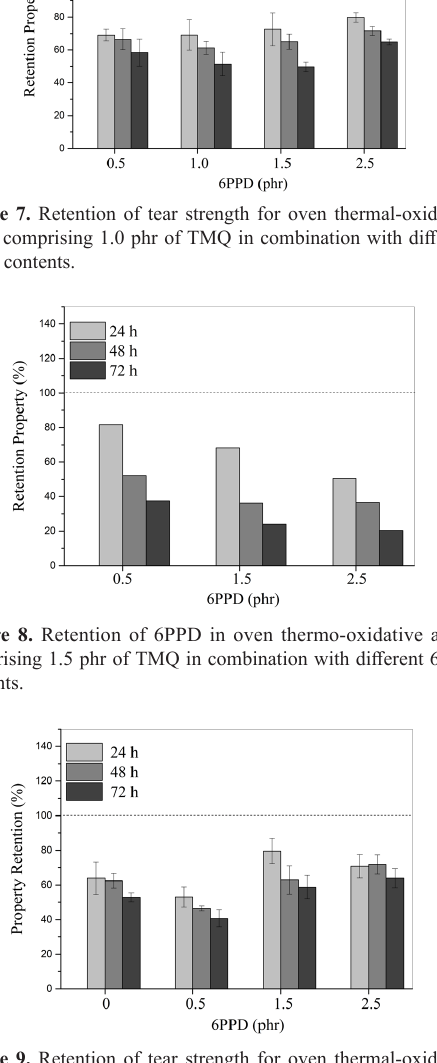
Figure 9. Retention of tear strength for oven thermal-oxidative aging comprising 1.5 phr of TMQ in combination with different 6PPD contents.